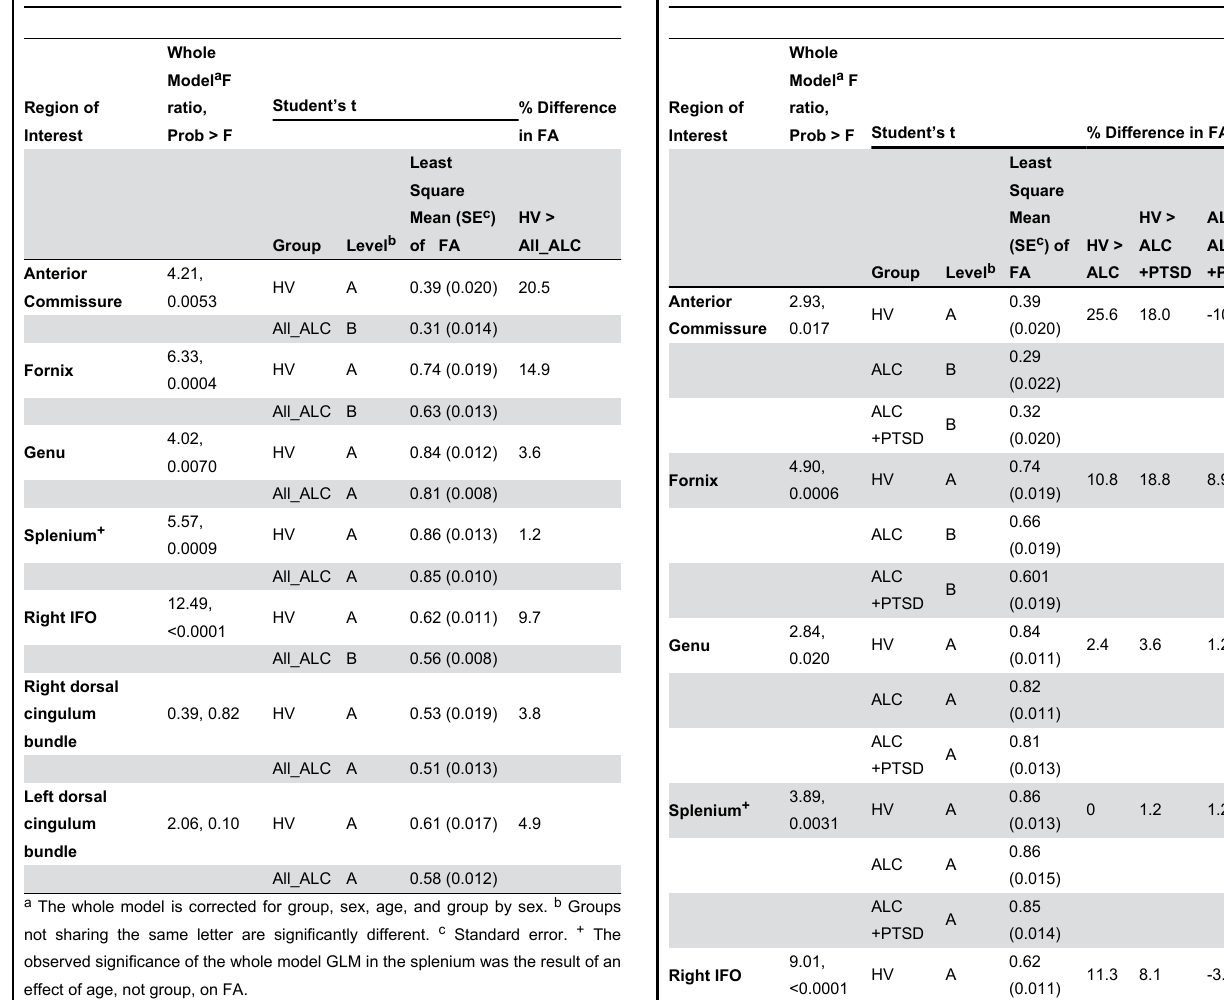
Table 2. Statistics of two-group Region of Interest analysis: HV vs All_ALC.